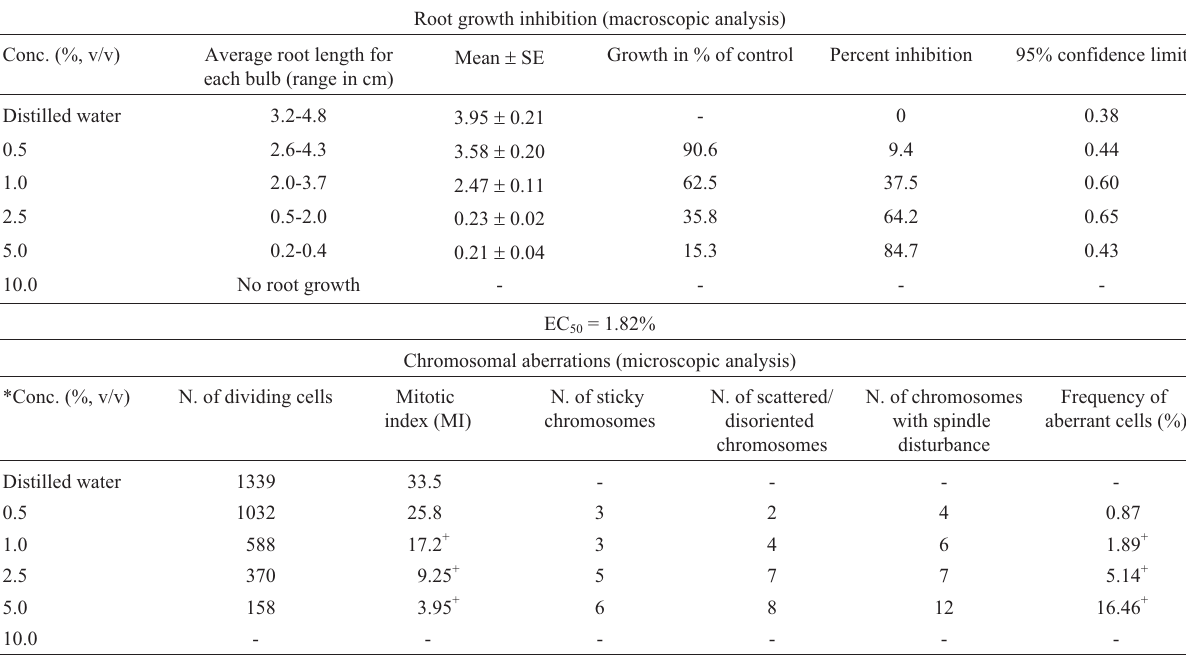
Table 2 - Inhibitory and cytological effects of the pharmaceutical effluent on Allium cepa root. Root growth inhibition (macroscopic analysis) Conc. (%, v/v)